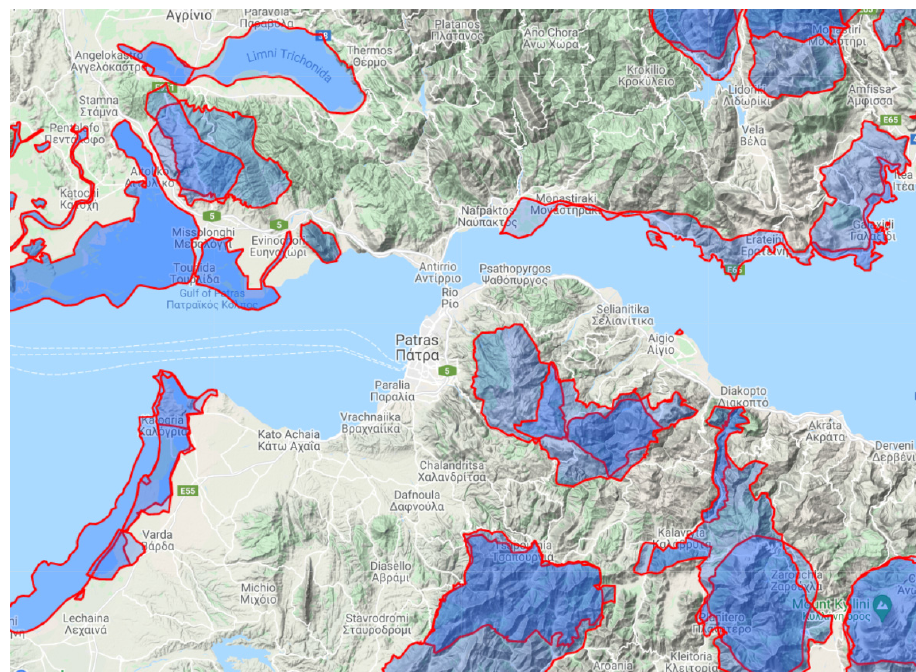
Figure 2. Μ ap with Natura 2000 areas distribution in wider area of interest [8]. Figure 2. Map with Natura 2000 areas distribution in wider area of interest